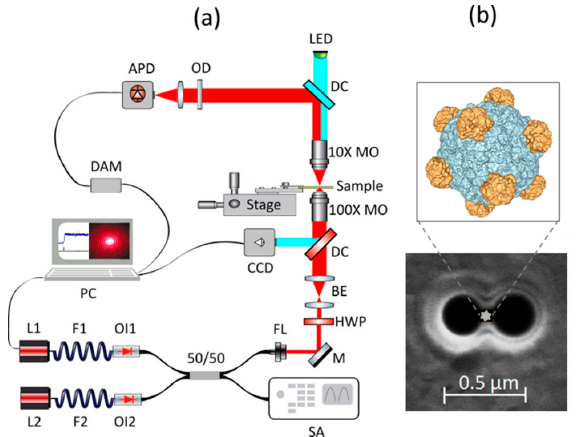
Figure 1. ( a ) Experimental set-up—(L1) tunable laser, (L2) fixed laser, (F1 and F2) optical fibers, (OI1 and OI2) optical isolators, (50/50) fiber coupler, (FL) fiber launcher, (SA) spectrum analyzer, (M) mirror, (HWP) half wave plate, (BE) beam expander, (DC) dichroic mirror, (CCD) charge-coupled device camera, (10× and 100× MO) microscope objectives, (LED) white light source, (OD) optical density filter, (APD) avalanche photo diode detector, (DAM) data acquisition module, (PC) personal